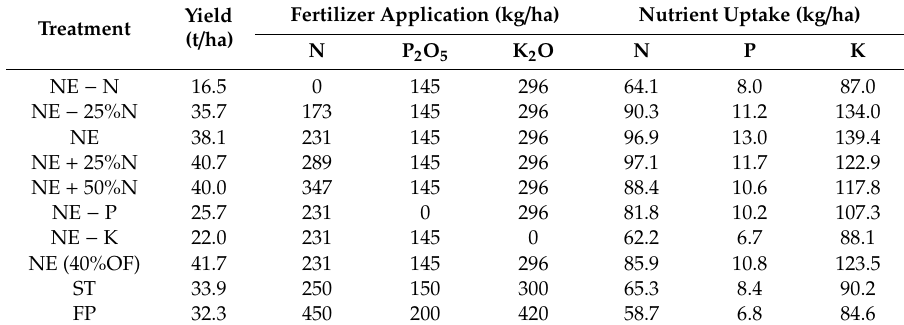
Table 3. Description of fertilization and nutrient uptake for watermelon in field experiments in Hebei province,